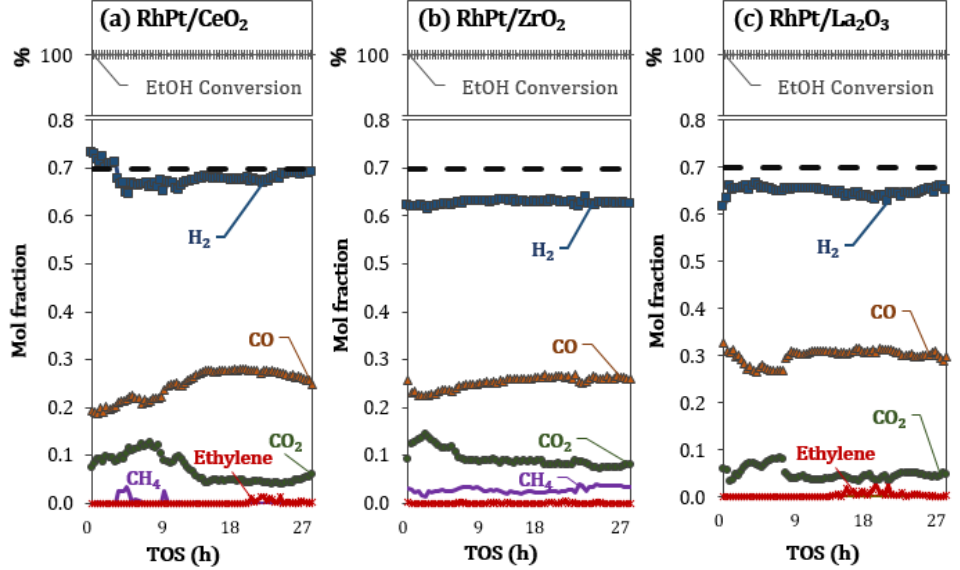
Figure 2. Product distribution (H 2 , CO, CO 2 , CH 4 , and ethylene) as a function of time on stream (TOS) on reduced ( a ) RhPt/CeO 2 ; ( b ) RhPt/ZrO 2 ; and ( c ) RhPt/La 2 O 3 . Dashed line: H 2 equilibrium. Reaction conditions: S/E = 3 and GHSV = 70,600 h − 1 at 700